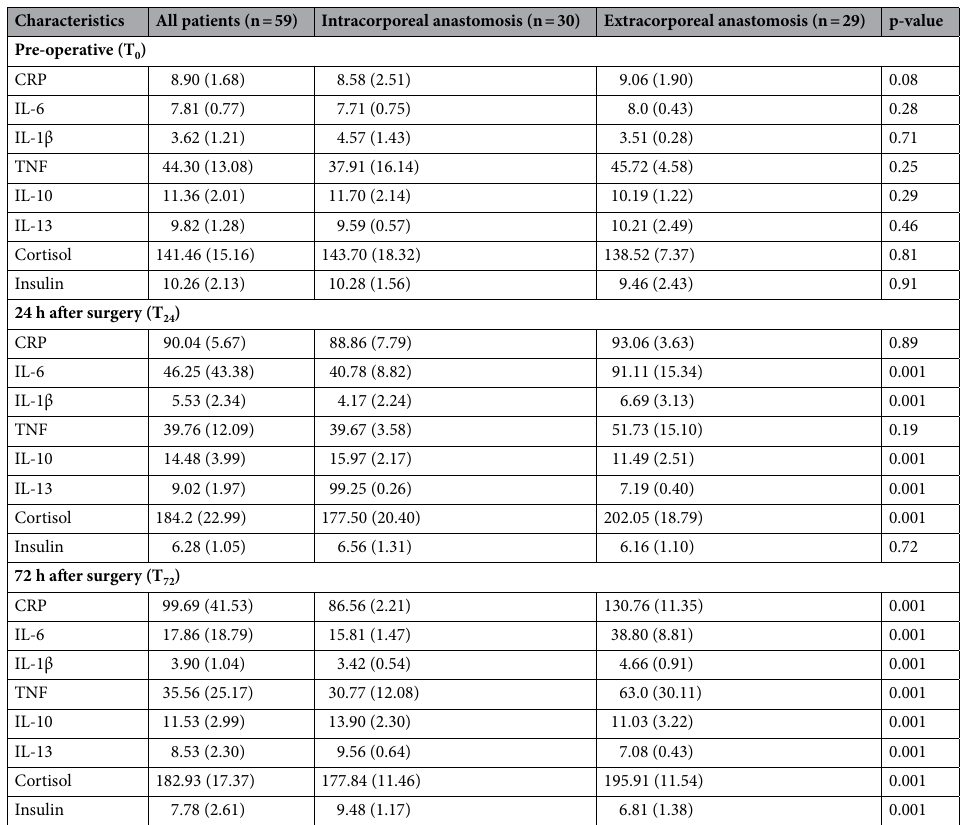
Table 6. Inflammatory mediators in patients with post-operative complications. Data were expressed as median (interquartile range). CRP C-reactive protein, TNF tumor necrosis factor, IL